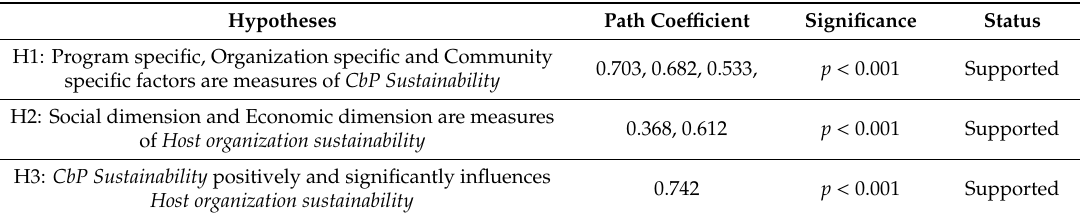
Table 10. Hypotheses accepted after data